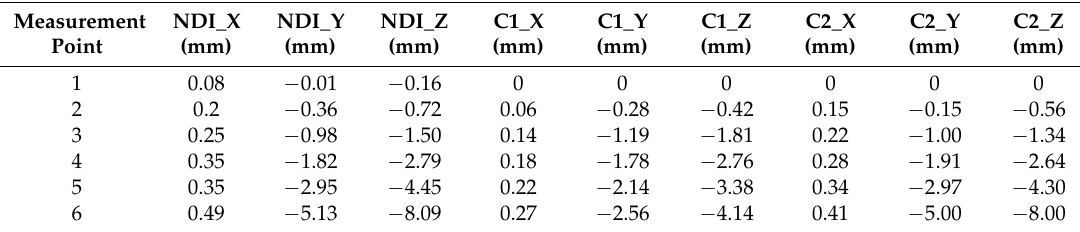
Table 8. Deformation displacement by NDI measurement and reconstruction with the C1 and C2 schemes in marker point for heavy load condition.